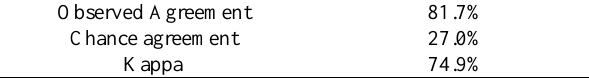
Table 2b. Cohen's kappa